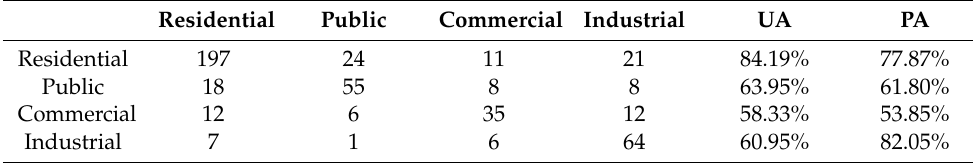
Table 7. Parcel Confusion matrix for Level I (4800 training & 485 testing